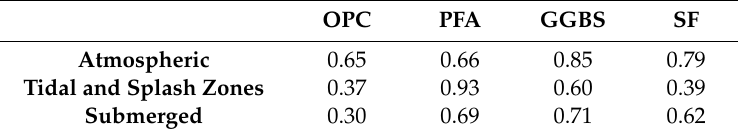
Table 6. Age factor of the chloride di ff usion coe ffi cient n cl .